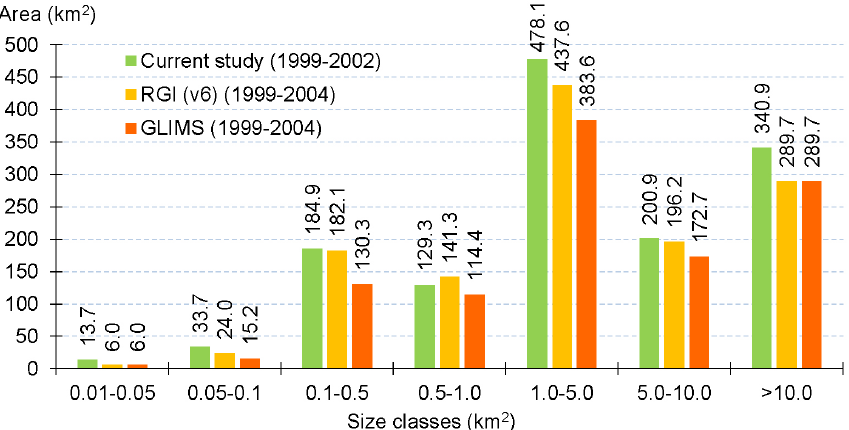
Figure 14. Comparison of cumulative glacier areas sorted for seven size classes for the RGI (v6), GLIMS, and current glacier inventory from